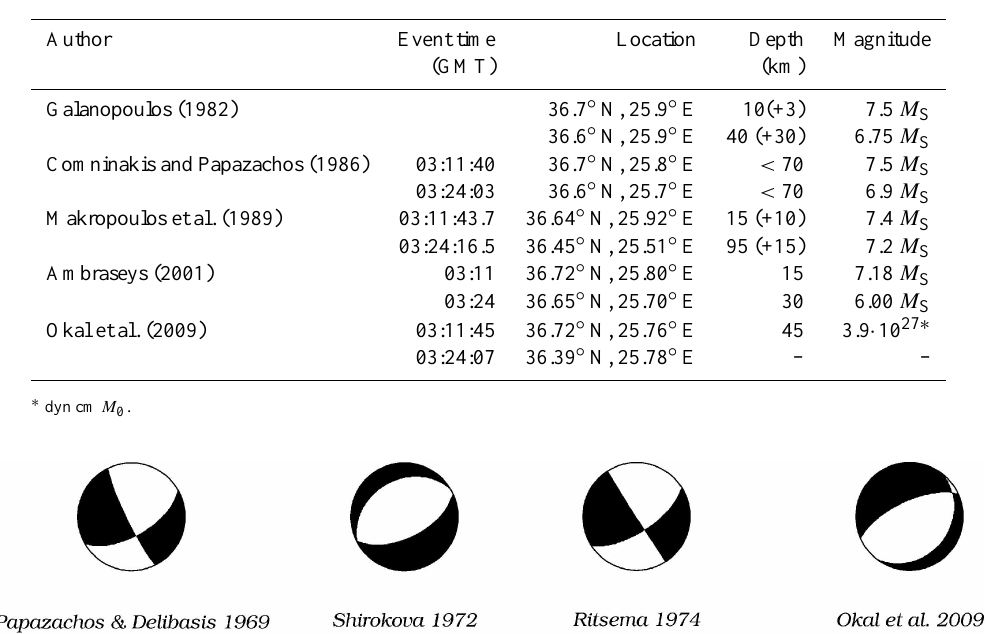
Table 1. Hypocenter parameters of the two earthquakes on 9 July 1956 from previous studies indicate a large uncertainty of hypocentral depth.